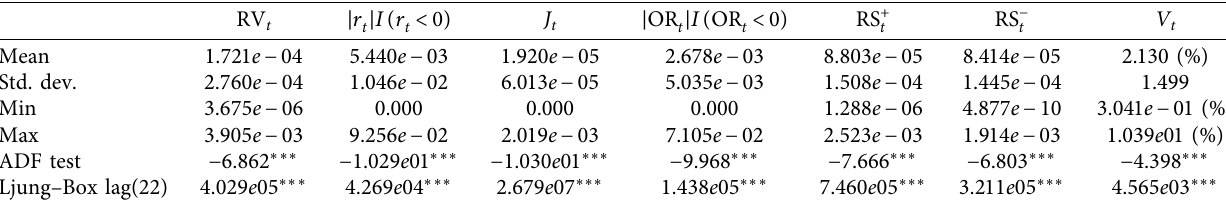
Table 1: Summary statistics of the variables.